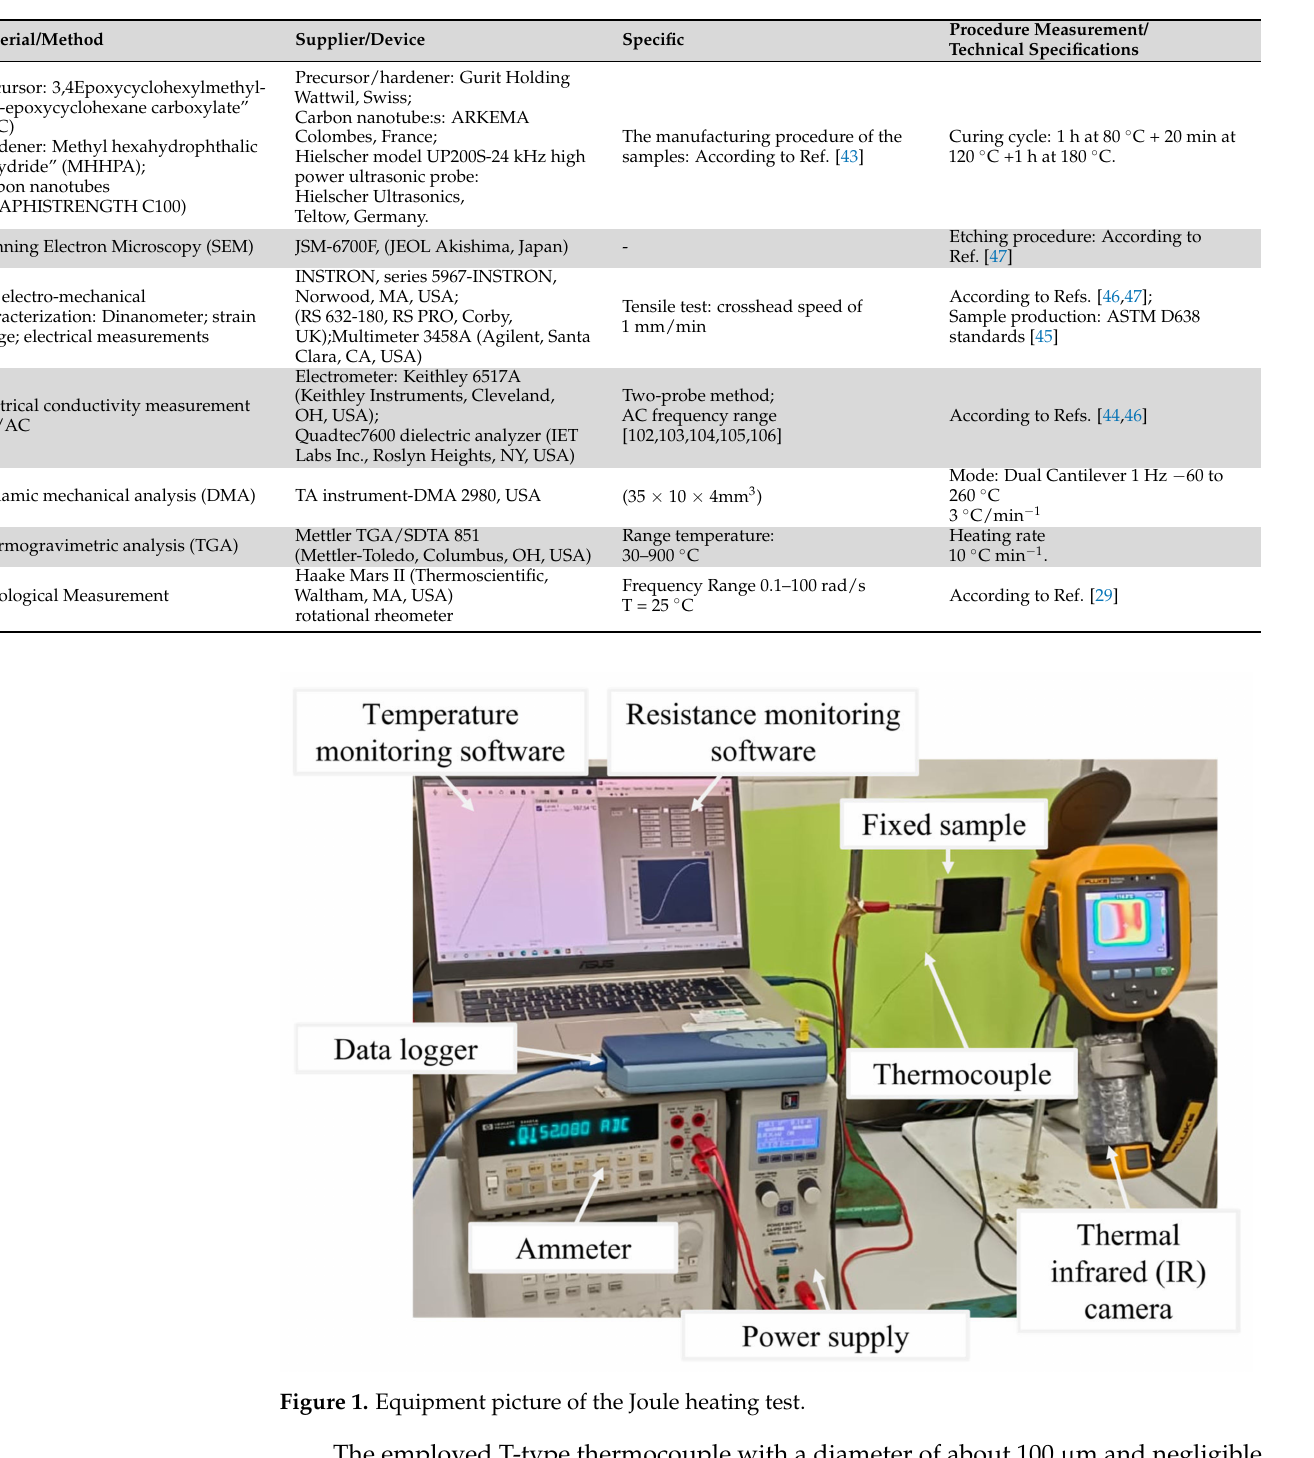
Table 1. Preparation procedure sample and characterization methods.